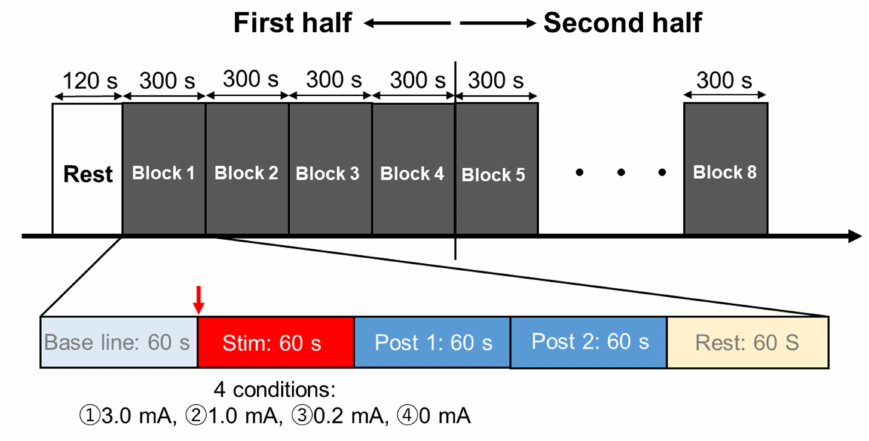
Figure 2. Experimental protocol in Experiment 2. The first half was divided into 4 blocks and the second half into 4 blocks, with four stimulus intensities (3.0 mA, 1.0 mA, 0.2 mA, 0 mA) assigned randomly to each